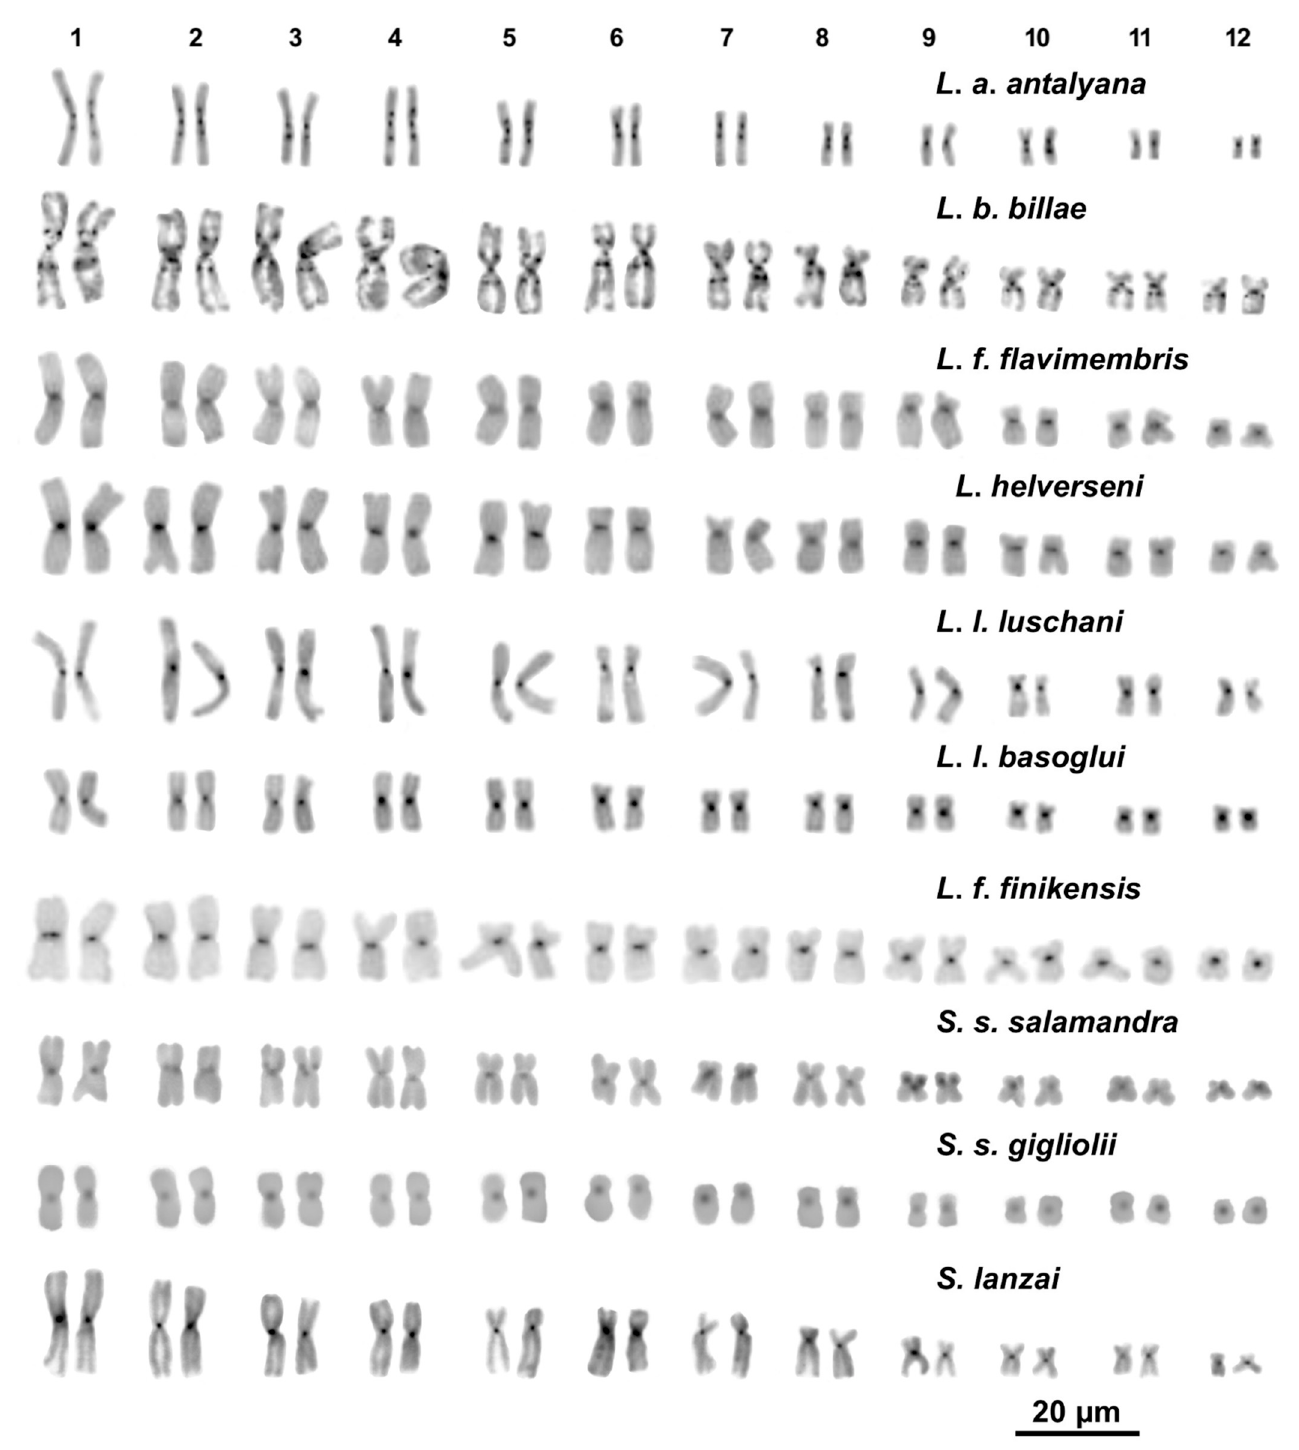
Figure 3. C-banding + Giemsa stained karyotypes of the examined taxa of Lyciasalamandra and Salamandra .